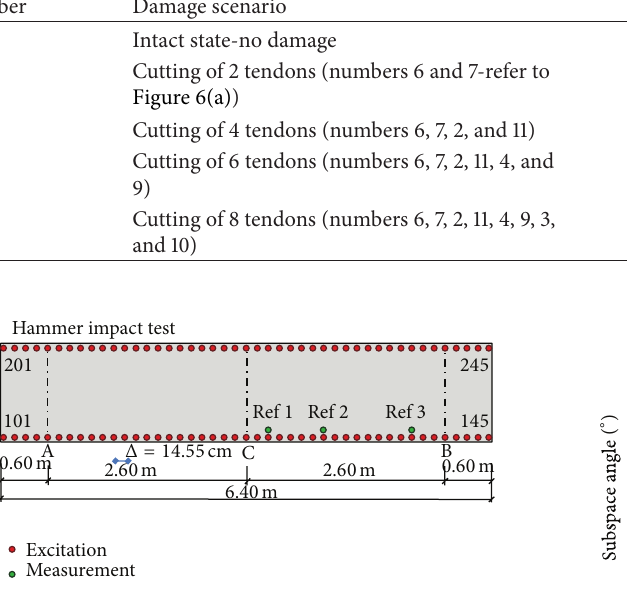
Figure 7: Measurement setup: impact point (101–145 and 201–245) and accelerometer positions (Ref. 1–Ref. 3).